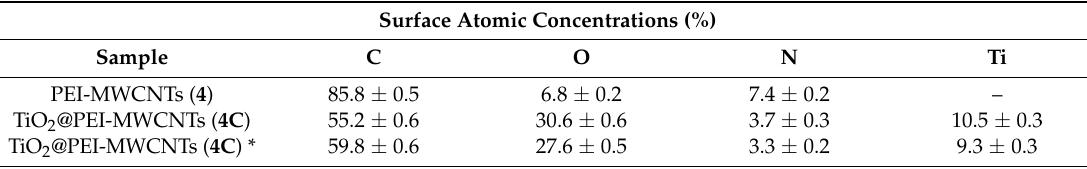
Table 4. XPS analyses of hybrid nanocomposites.